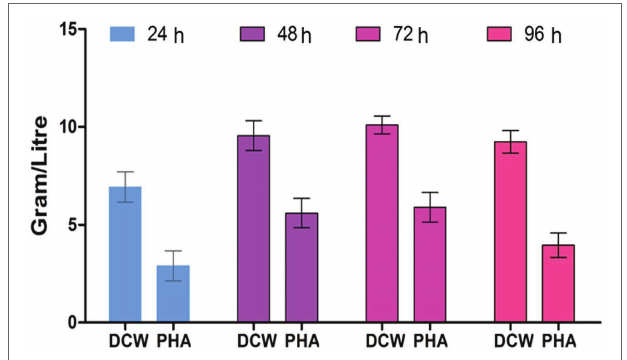
FIGURE 5 | Effect of incubation period on PHA production by P. aeruginosa EO1.